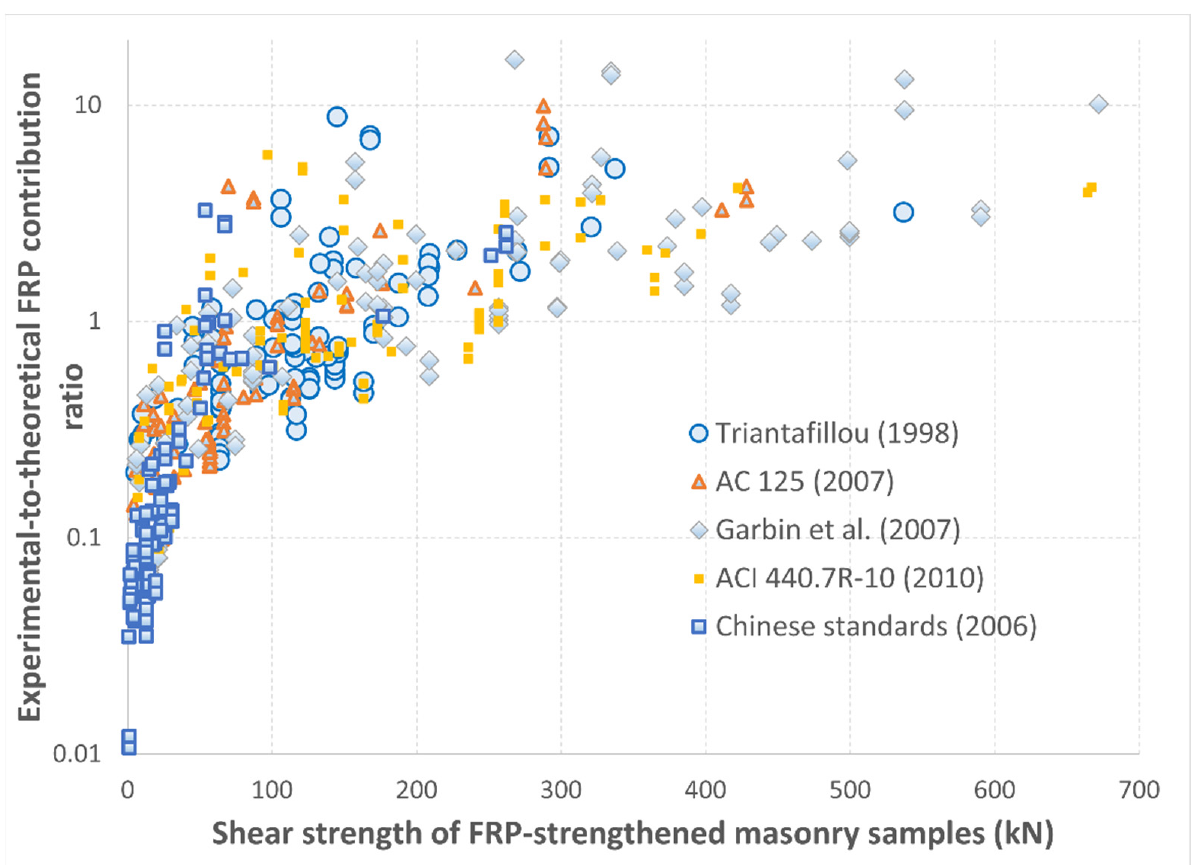
Figure 8. Estimated shear strength of FRP-strengthened masonry samples according to the five models from Table 3 vs. experimental-to-theoretical FRP contribution ratios.